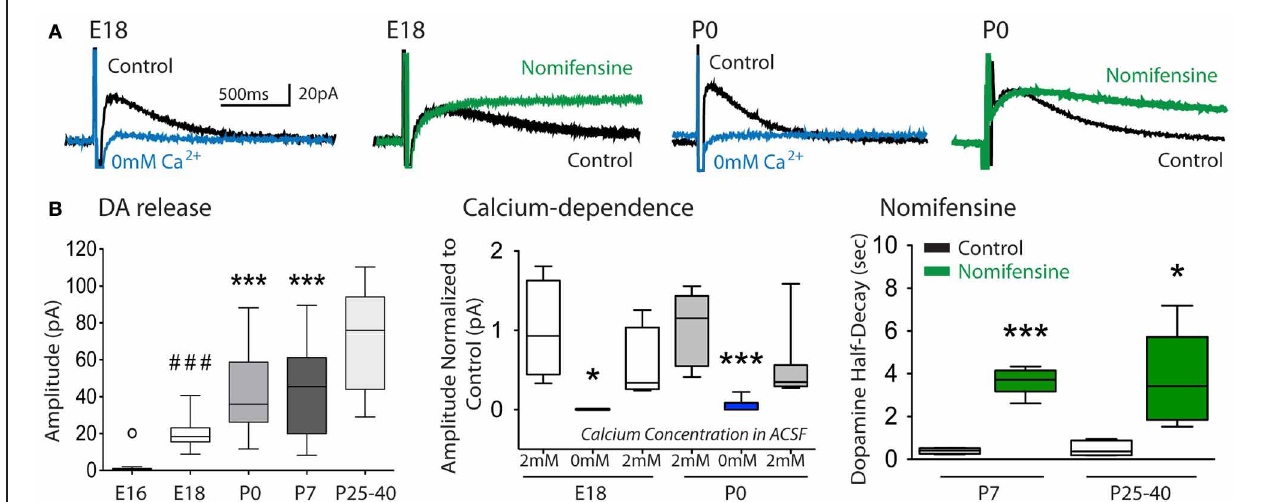
and P0 with recovery after returning to control ACSF (middle), and its half-decay in the presence of nomifensine as a function of age (right). DA release: ◦ p < 0 . 05 compared to E18; ### p < 0 . 001 compared to P0, P7, P26–40; ∗∗∗ p < 0 . 001 compared to P26–40; one-way ANOVA. Calcium-dependence: ∗ p < 0 . 05, ∗∗∗ p < 0 . 001 compared to 2mM Ca 2 + , paired t -test. Nomifensine: ∗ p < 0 . 05, ∗∗∗ p < 0 . 001 compared to control, paired t